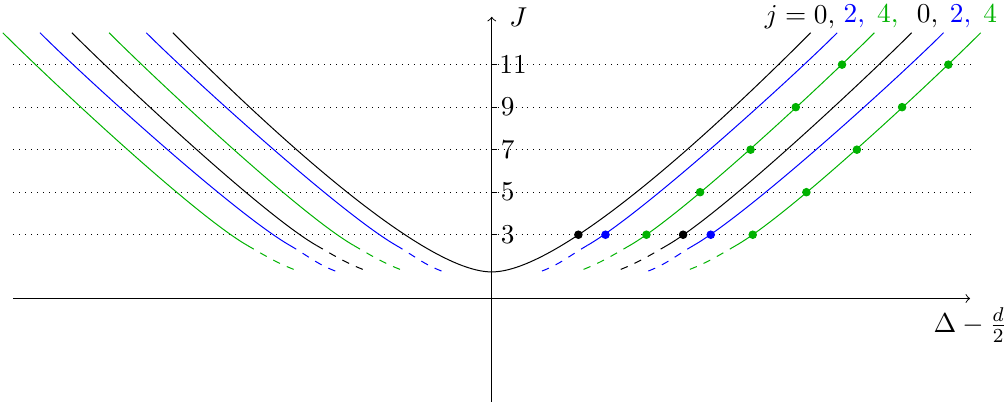
Figure 2 . Chew-Frautschi plot of light-ray operators in the E × E OPE in a hypothetical CFT. We show Regge trajectories of even signature operators with transverse spins j = 0 (black curves), j = 2 (blue curves), and j = 4 (green curves). Light-ray operators that appear in the E × E OPE are marked with dots. They include operators with spin J = 3 and transverse spins j = 0 , 2 , 4 . (These are the “low transverse spin” terms described in [1].) In addition, there are primary descendants of light-ray operators with transverse spin j = 4 and spin J = 5 , 7 , 9 , . . .